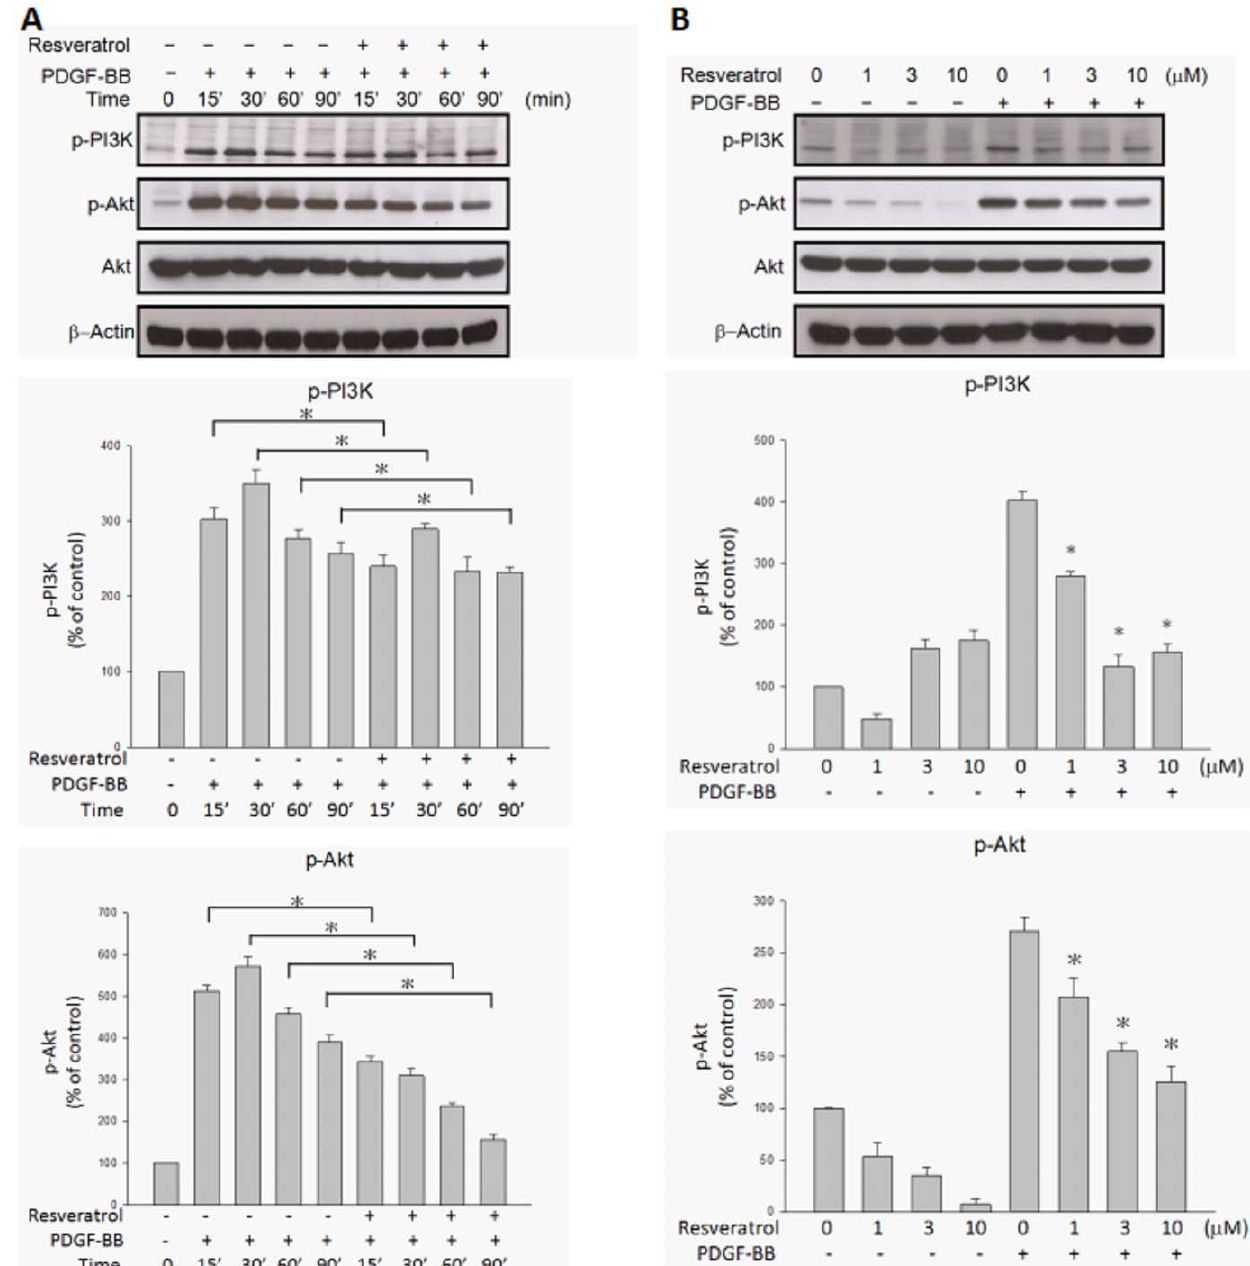
Figure 5. PDGF-BB-induced tyrosine and PDGFR b phosphorylations were inhibited by resveratrol in a time- and concentration- dependant manner. ARPE19 cells were treated with the indicated lengths of time of PDGF-BB (20 ng/ml) and preincubated with or without resveratrol (10 m M) at 37 u C (A). After being further preincubated for the indicated concentrations of resveratrol and incubated with or without PDGF- BB (20 ng/ml) at 37 u C for 30 minutes, the cells were collected and their lysates were analyzed by Western blot analysis (B). The changes in phosphorylated tyrosine, PDGFR a and PDGFR b expression were evaluated. The quantitative data of western blot are shown below the panels which are expressed as percentage of control and represent mean 6 standard errors (SE) of the four independent experiments. *p , 0.05 significantly differs from same indicated time of cells stimulated PDGF-BB only (A) and *p , 0.05 significantly differs from PDGF-BB-stimulated cells (the fifth bar) (B).